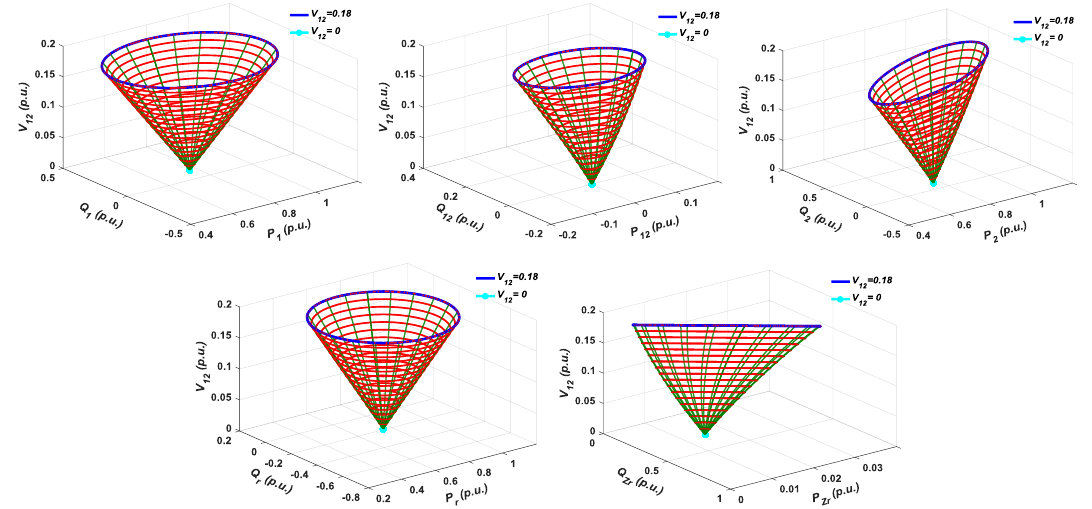
Figure 5. The spatial power flow operation surfaces when V r =1, δ = –π/8.